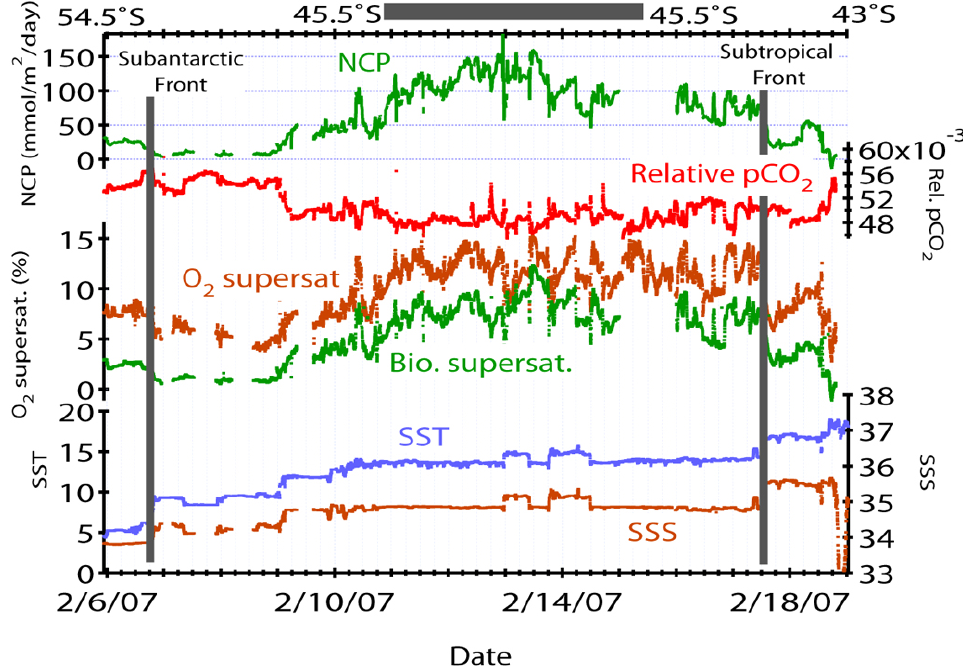
Fig. 2. SAZ-Sense North-bound transect NCP (from in situ O 2 /Ar), uncalibrated p CO 2 (from EIMS mass 44 measurements), total (optode) and biological (EIMS) oxygen supersaturation, and sea surface temperature (SST) and salinity (SSS). Approximate position of fronts is also